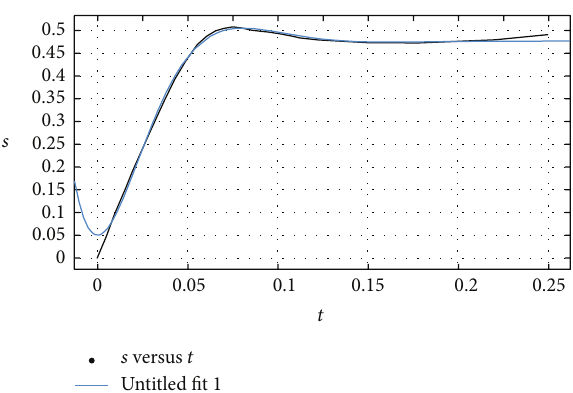
Figure 11: Curve fit with imaginary